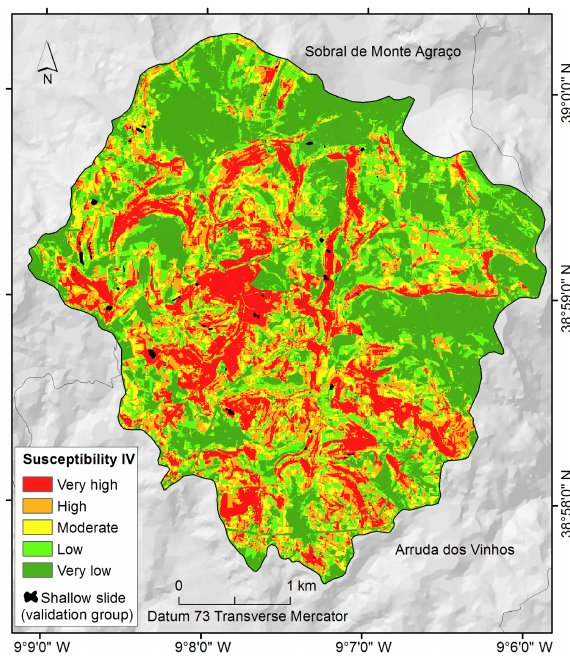
Figure 6. IV Shallow slide susceptibility map.